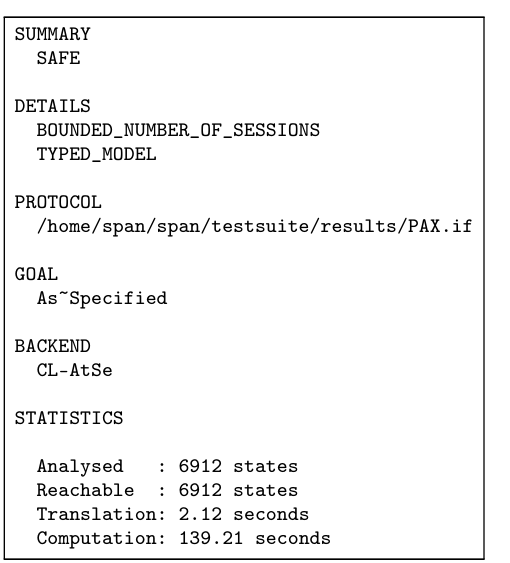
Figure 18. PAX’s framework in AVISPA. Figure 19. PAX’s result in CL-AtSe.